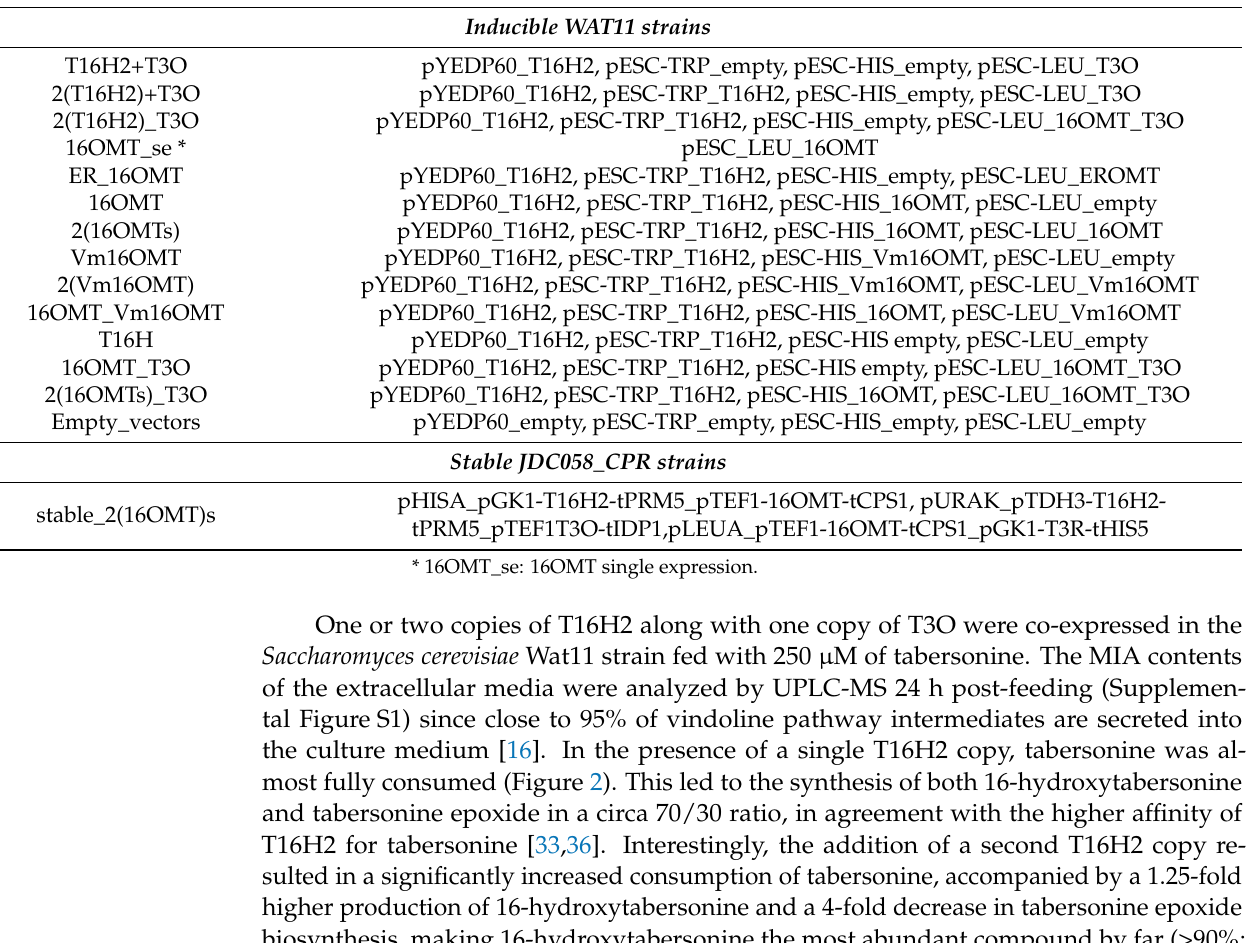
Table 1. Yeast strains and the respective plasmids used for the transformation. Strains Plasmids Inducible WAT11